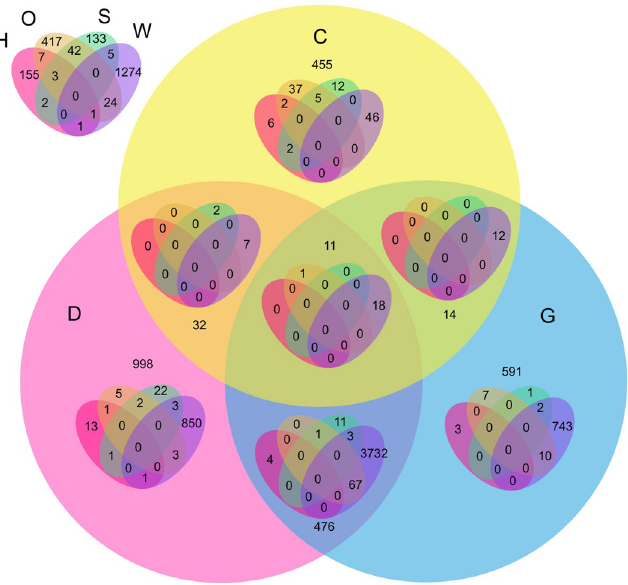
Figure 6. 7-set Venn diagram of gene ids present in C subunit across all stress conditions. H: Heat, O: Osmotic, S: Salt, W: Wounding, D: Drought, C: Cold, G: Genotoxic. The 7-set Venn diagram illustrates the count of genes in all 127 possible